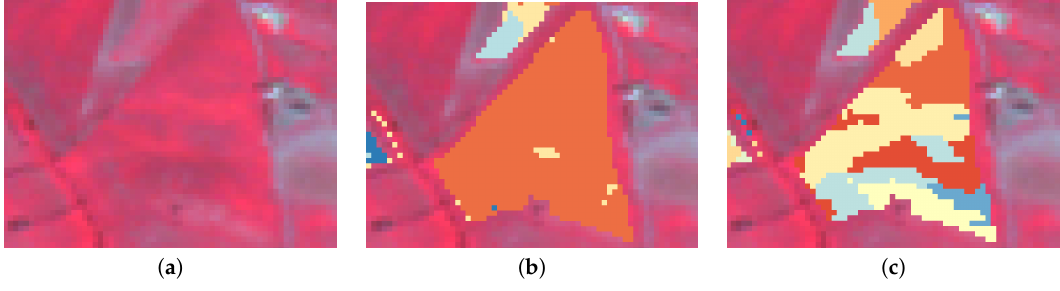
Figure 8. ( a ) False color image of a grassland acquired on 30 April 2015. The same grassland clustered using HDDC on multitemporal data with an initial clustering into ( b ) 8 clusters and ( c ) 150 clusters. Each cluster is represented by one